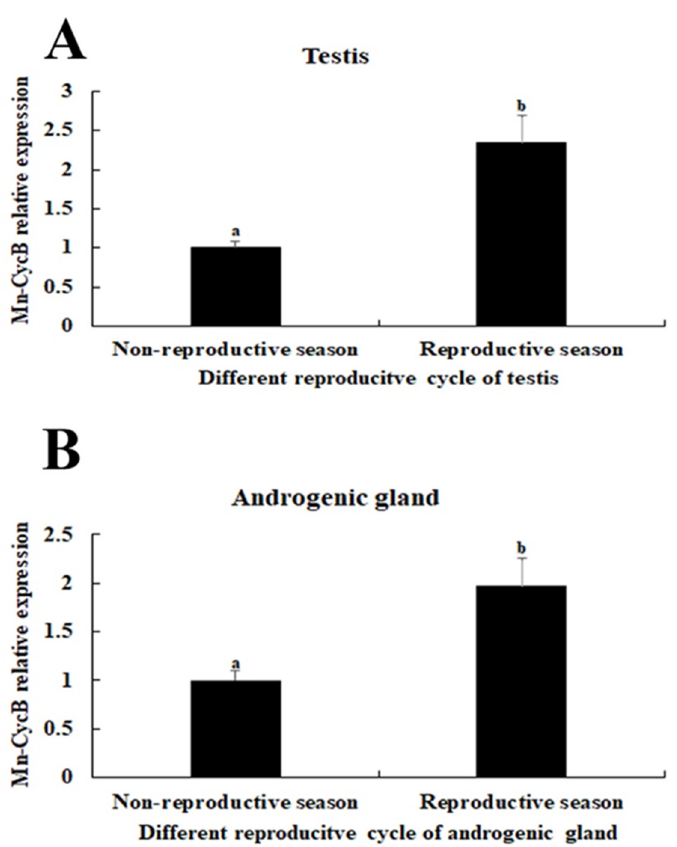
Figure 6. Mn-CycB expression in the testis and androgenic gland of prawns collected during the reproductive and non-reproductive seasons. Lowercase letters (a, b) on the bars indicate expression differences between different tissue samples (independent sample t-tests). ( A ) Mn-CycB expression in the testis. ( B ) Mn-CycB expression in the androgenic gland.